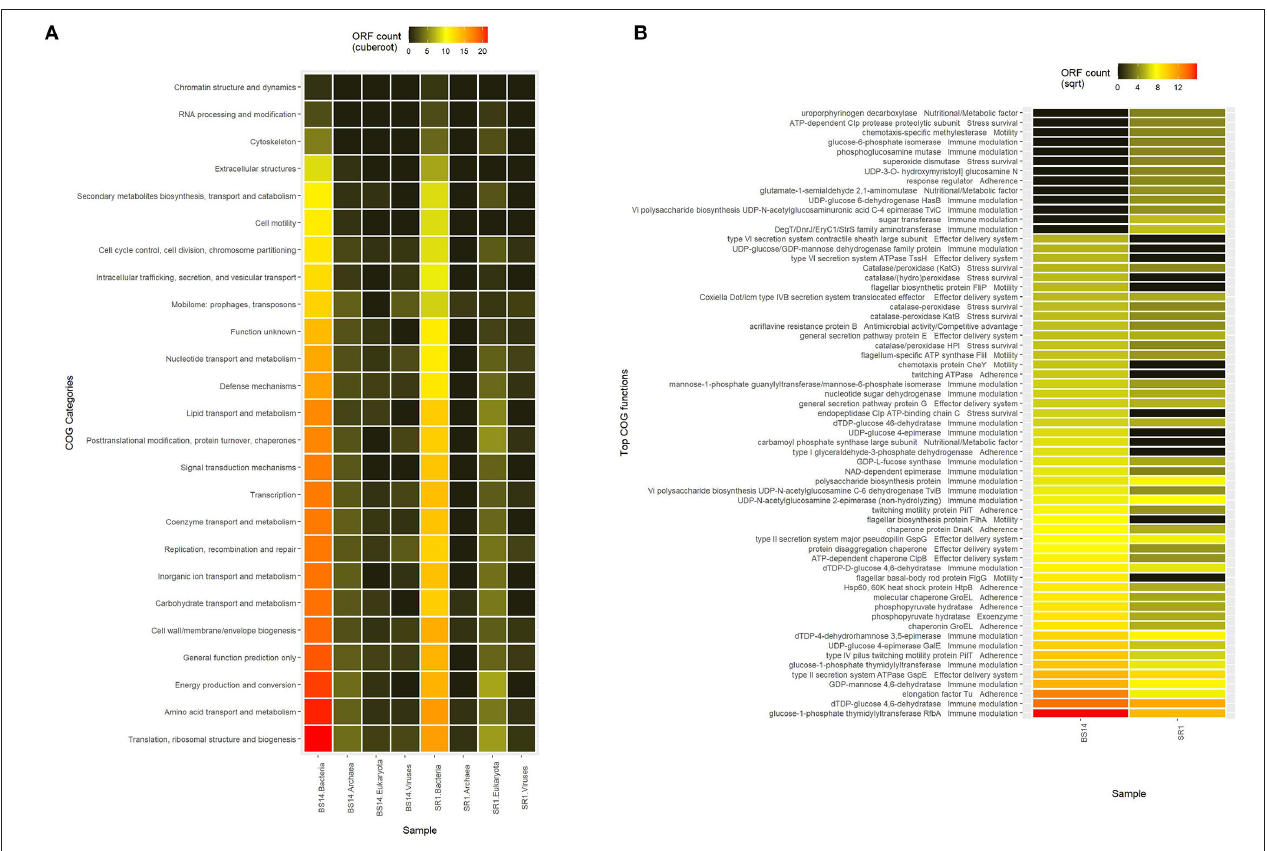
FIGURE 3 | (A) Heatmap showing the Cluster of Orthologous Genes (COG) functional assignment of BS14 and SR1 at the Kingdom level and (B) heatmap showing the top 50 COG functional assignments of BS14 and